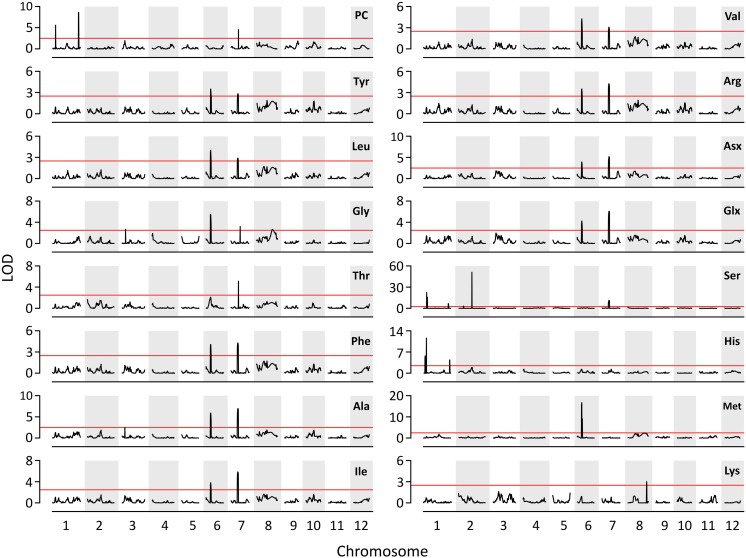
The results of QTL analysis for AAC and PC. Red horizontal line indicates LOD threshold (>2.5).